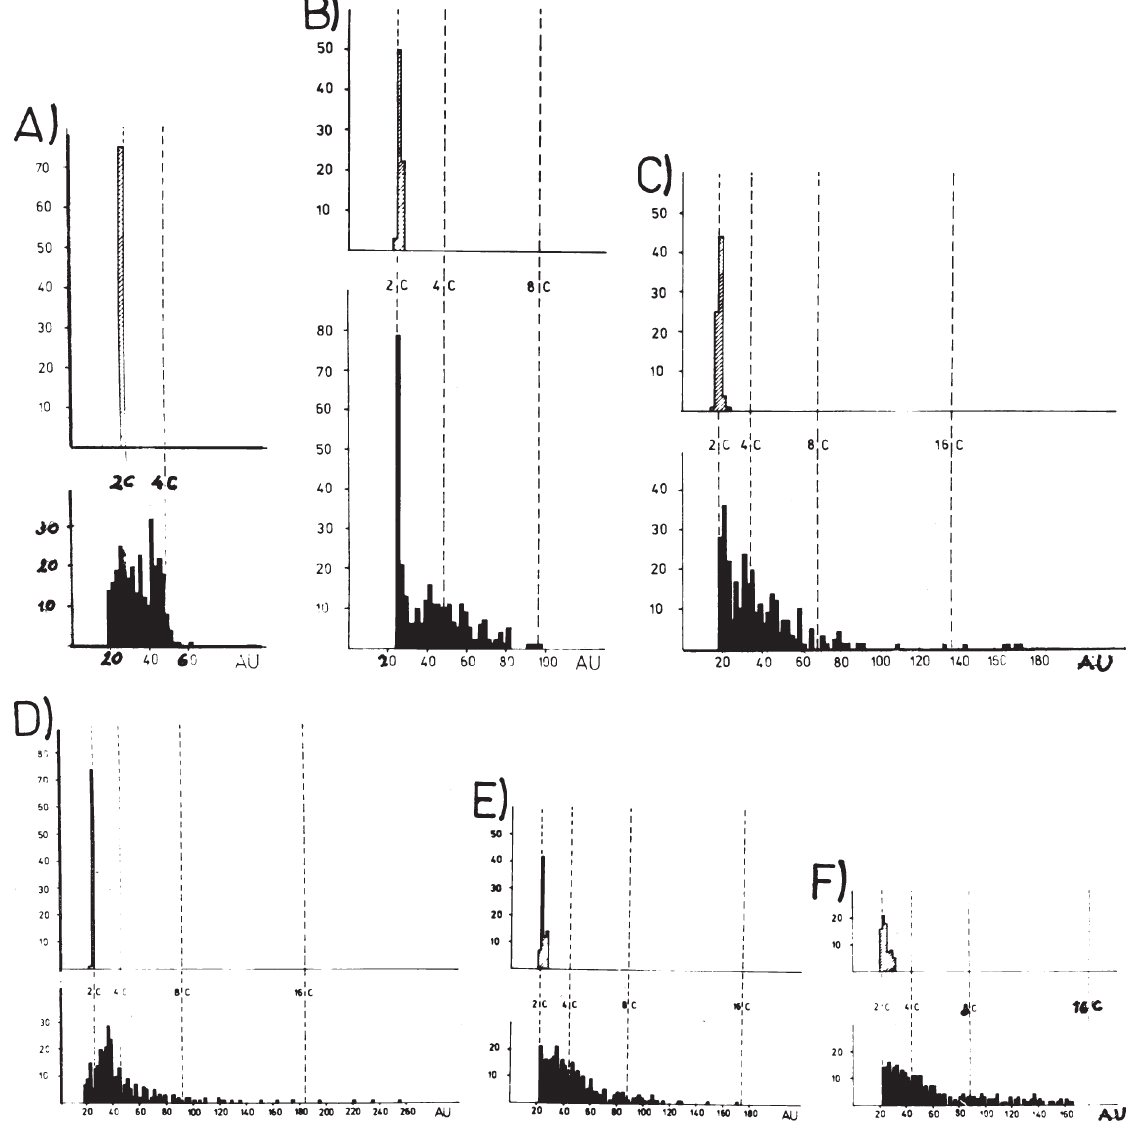
Fig. 1. Histograms of nuclear profile DNA contents, pooled between patients (arbitrary units). A: normal gastric mucosa; B: chronic atrophic gastritis; C: chronic hypertrophic gastritis; D: gastric ulcers with carcinoma; E: adenomatous gastric polyps with carcinoma; F: gastric